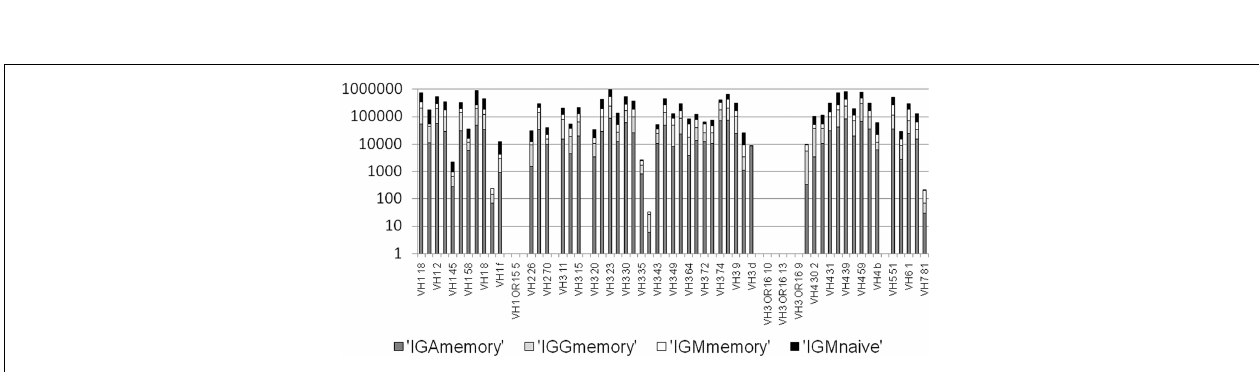
FIGUREA2 | Log offspring number ratio values for S and NS mutations as given in FigureA1 . For each mutation its region is give (1 or 2), its type (S or NS), its position along the gene in nucleotides, the mutation itself in nucleotides, and amino acids, as well as the LONR score.The distribution of LONR scores is used to assess selection.